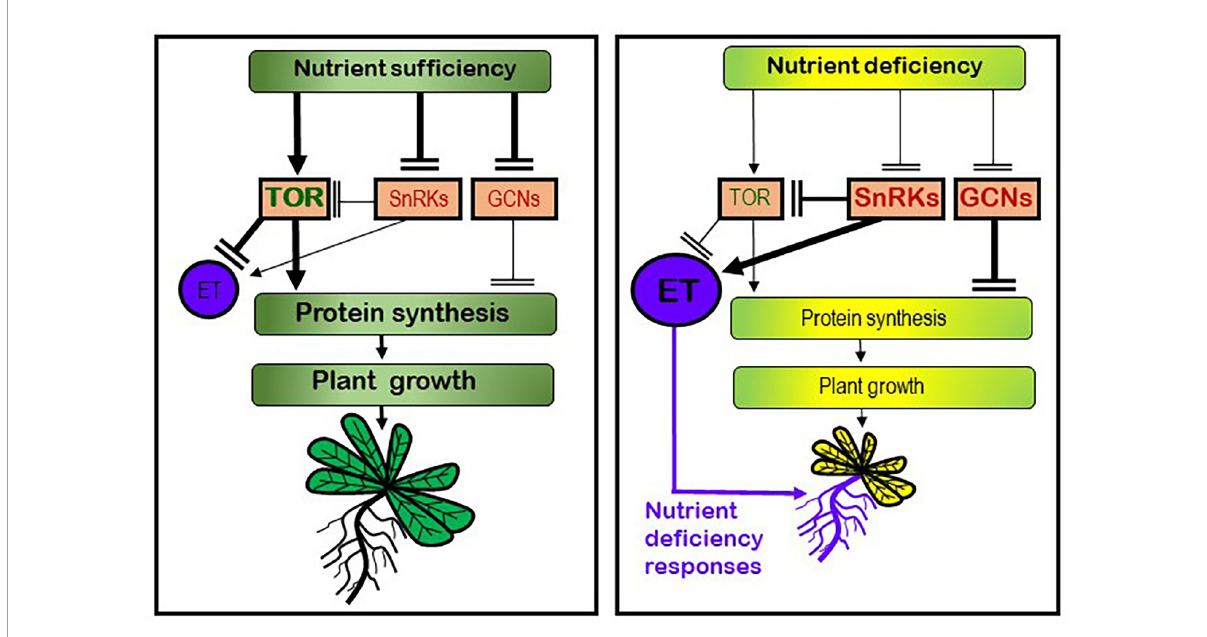
FIGURE1 Working model to explain the possible roles of the TOR/SnRKs/GCNs regulatory system and ethylene (ET) in plant growth and development of nutrient deficiency responses. Under nutrient sufficiency, the TOR kinase is activated leading to an increase of protein synthesis and meristem activity, and consequently to a promotion of plant growth. In this condition, TOR blocks ET synthesis and signaling. Under nutrient deficiency, other kinases, like SnRKs and GCNs, are activated leading to inhibition of TOR, protein synthesis, meristem activity, and growth. In this condition, ET synthesis and signaling is enhanced, which leads to the activation of nutrient deficiency responses, mainly in roots, aimed at acquiring the deficient nutrient from the medium. Based on Robaglia et al. (2012), García et al. (2015, 2021a,b), Lucena et al. (2015), Dobrenel et al. (2016a), Rodríguez et al. (2019), Zhuo et al. (2020), Fu et al. (2021), and Romera et al.